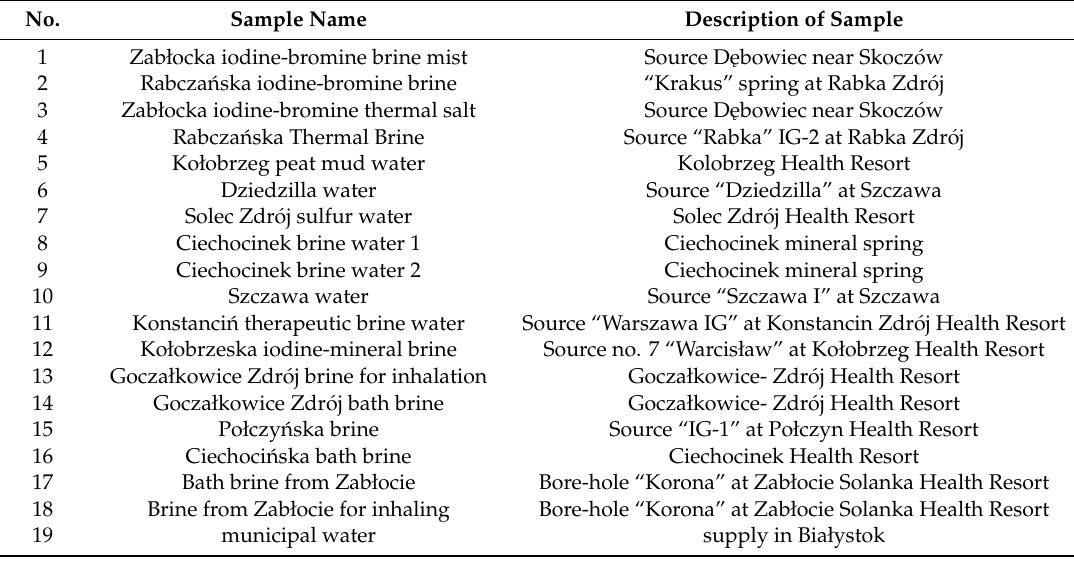
Table 1. Description of